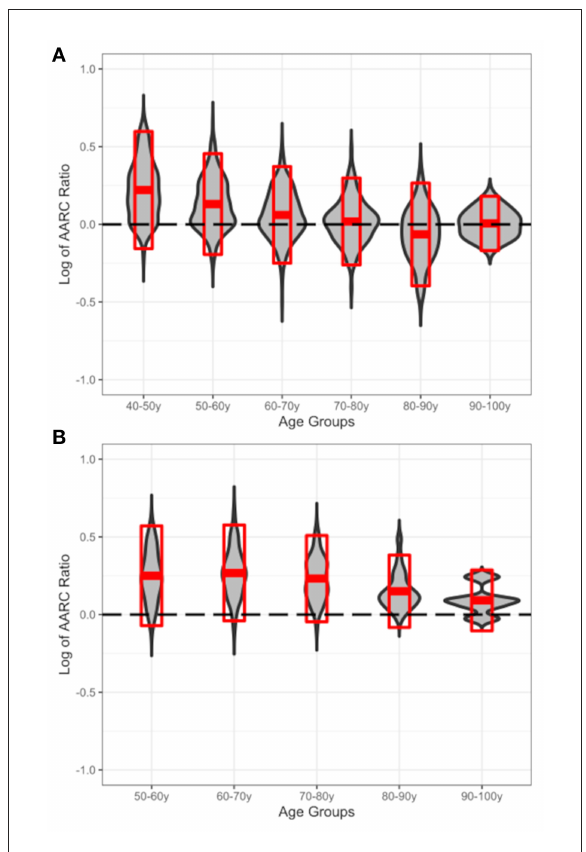
FIGURE1 Displayed is the ratio of AARC-gains/AARC-losses (y-axis; log10-transformed for symmetry of the scale) across chronological age groups (x-axis). (A) The sample from rural Burkina Faso and (B) the German reference sample. The gray violin plot shows the distribution for gains/losses in the respective age groups; superimposed red crossbars display the area of Mean ± 1 SD within those groups. The dashed reference line indicates a balance between gains and losses (i.e., log of 1:1 ratio), and higher values indicate more gains than losses and lower values vice versa